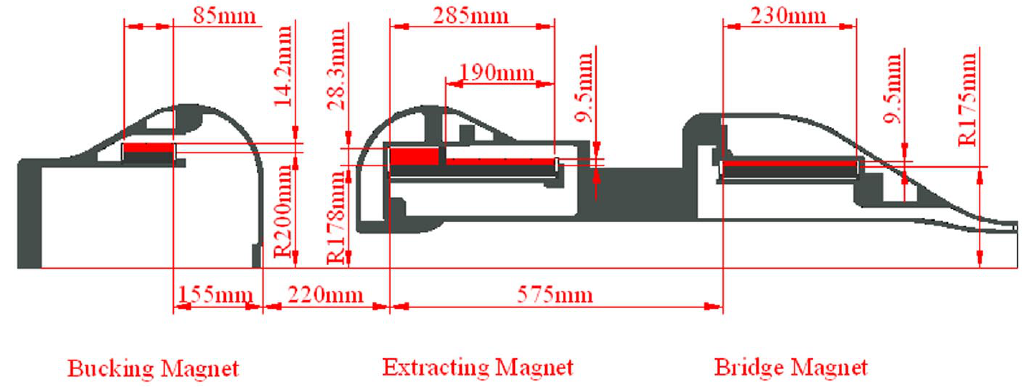
FIG. 8. (Color) Scheme of the magnets in the diode